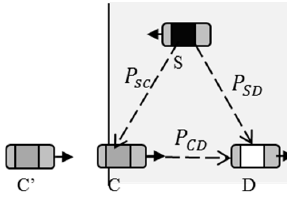
Figure 3. Three-node communication model.